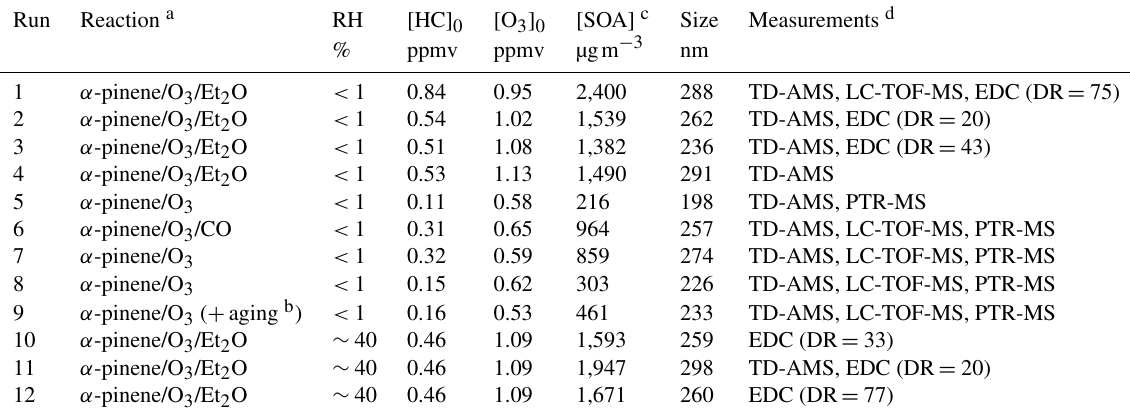
Table 1. Experimental conditions, particle mass concentration, and mean particle